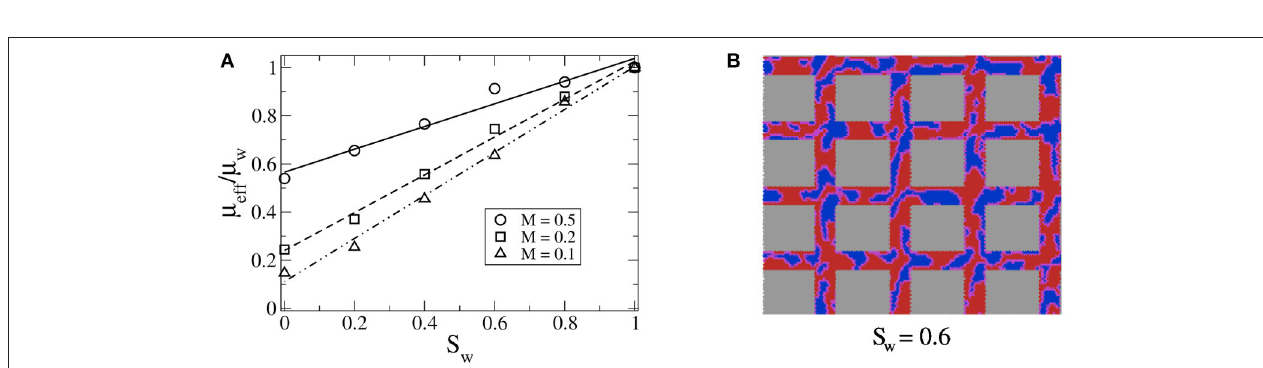
FIGURE 3 | (A) Plot of ( µ eff /µ w ) α obtained from lattice Boltzmann simulations with more viscous wetting fluid which shows α (B) Typical steady-state distribution of the fluids, where the blue and red are the more viscous (wetting) and less-viscous (non-wetting) fluids, respectively.